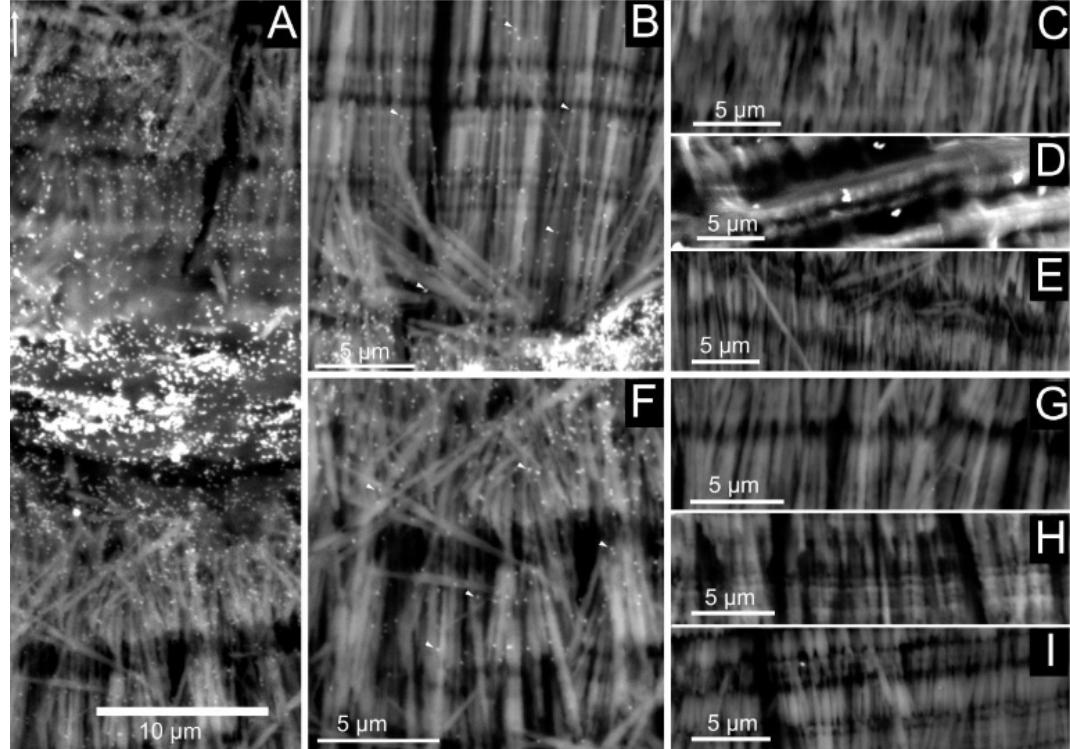
Figure 10. Immunogold labeling of shell preparations with anti-P95 antibody. The left panel ( A ) shows a general view of the shell wall, while the middle panel represents magnification of the outer ( B ) and inner ( F ) layers. The right panel corresponds to different negative controls, namely without the first antibody (anti-P95; C, G ), without the second antibody GAR-AP (Goat anti-Rabbit, conjugated to alkaline phosphatase, D, H ) and an absolute blank ( E, I ). An intense staining is observed in the central ”core” layer (A), while the staining is more diffuse in the surrounding fibrous layers ( B, F ).